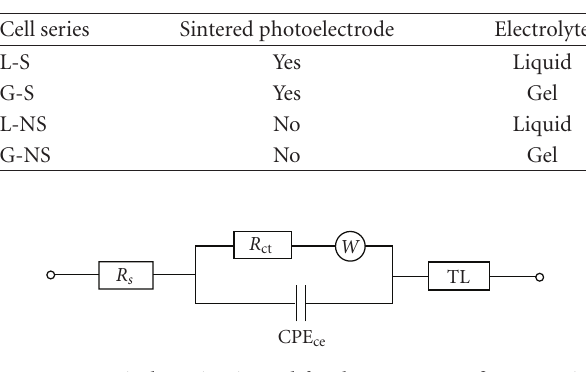
Figure 1: Equivalent circuit used for the EIS spectra fits. R s : series resistance of the cell. TL : transmission line element, as introduced by Bisquert, Fabregat-Santiago et al. (e.g., [24]), modeling